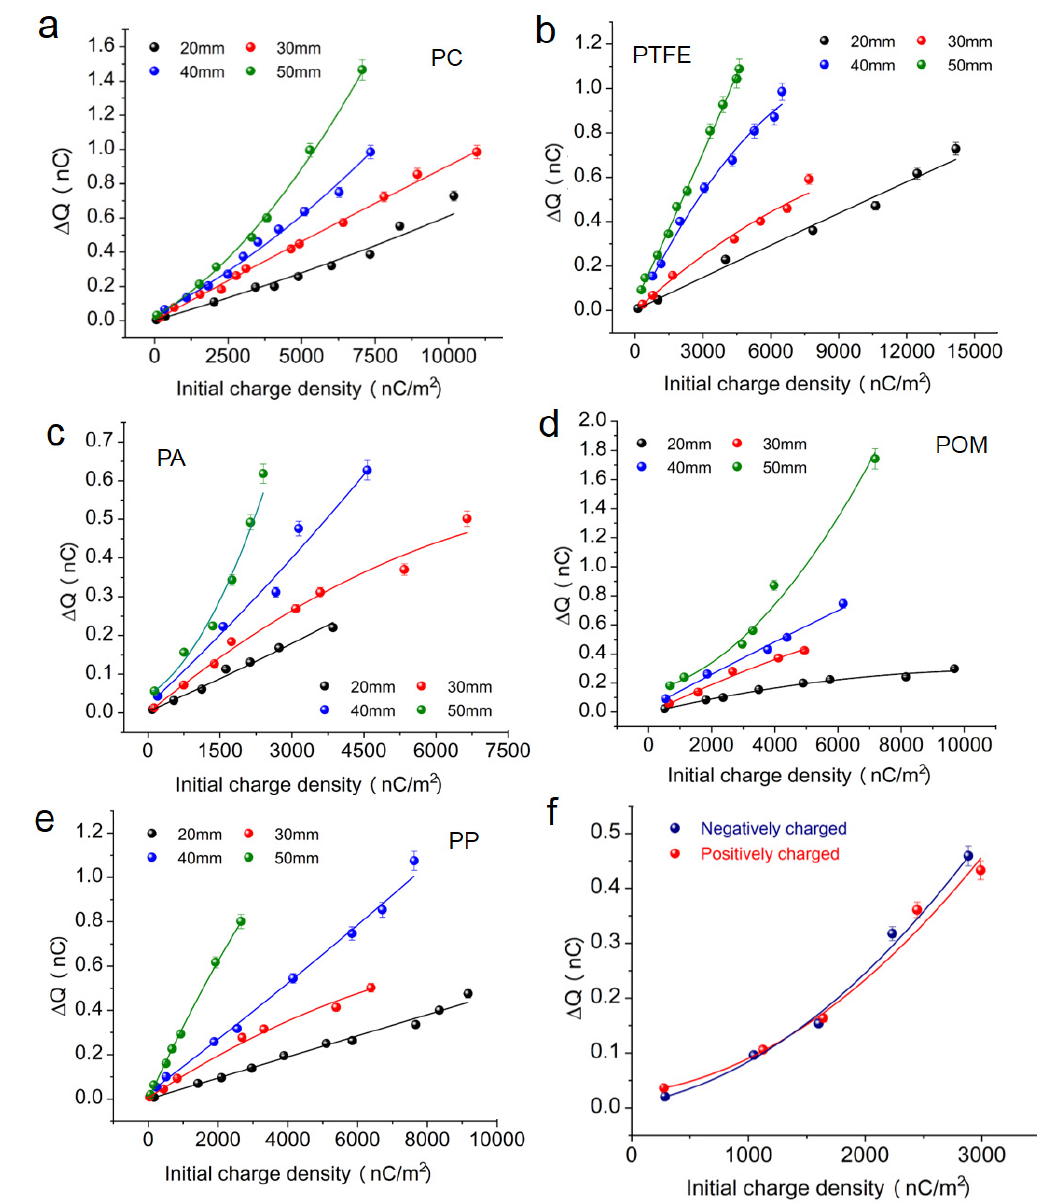
Figure 4. Effects of initial charge on polymer surface at gas–solid contact electrification. ( a – e ) The relationship between the transferred charge and initial charge of the polymer surface in the process of gas–PC, gas–PTFE, gas–PA, gas–POM, and gas–PP contact electrification. ( f ) The effect of initial charge polarity on electron transfer.